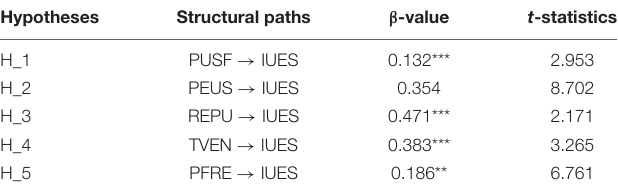
TABLE 10 | Test for